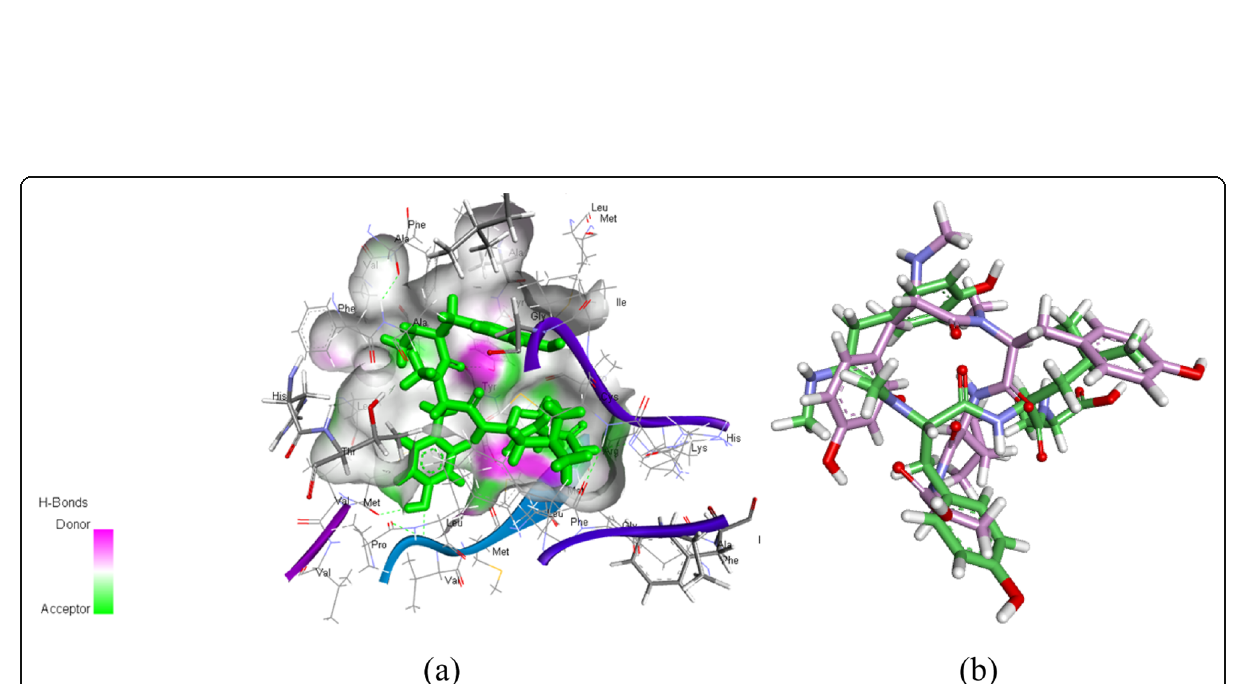
Fig. 9 RMSD plot and protein-ligand contacts for CYP51-N-methyltyrosyl-N-methyltyrosyl-leucyl-alanine complex (UNPD86509)